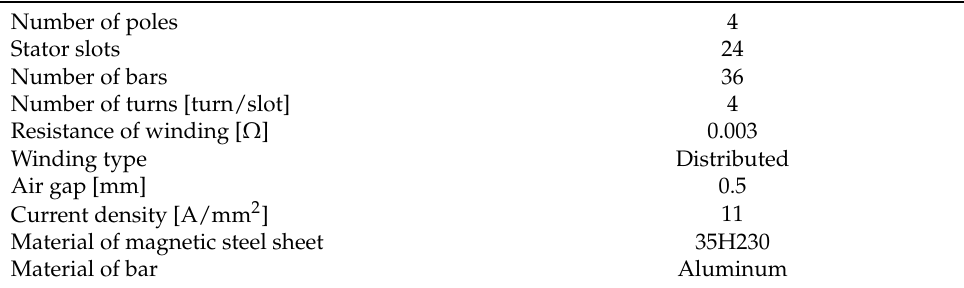
Table 4. Specifications of IM.